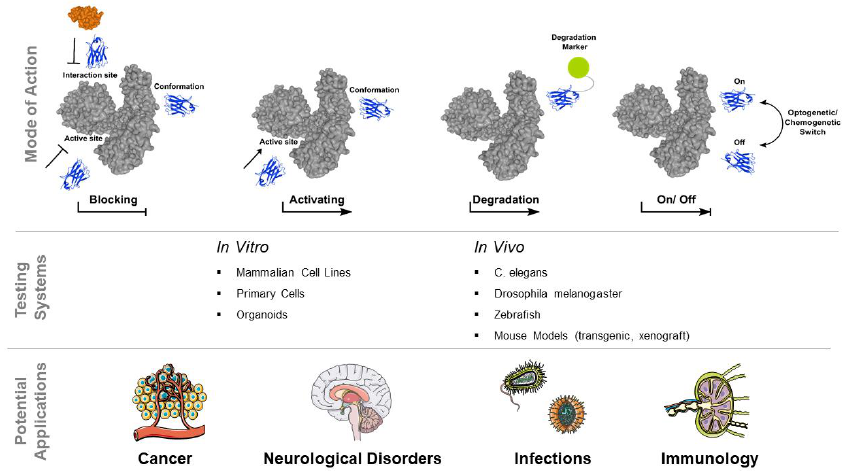
Figure 2. Intrabodies as intracellular modulators. Graphical representation how intrabodies